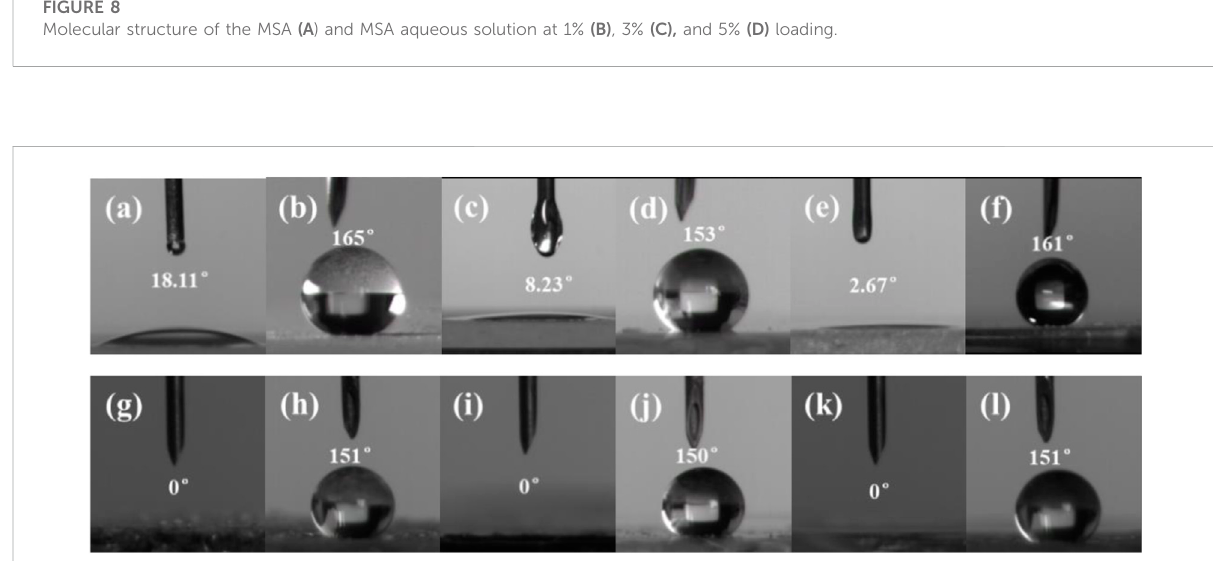
FIGURE 9 In fl uence of the MSA on the contact angle of the solid surface: the water-phase contact angle of the rock core before (A) and after treatment (B) , of the metal before (C) and after treatment (D) , and of the fi lter cake before (E) and after treatment (F) ; oil-phase (paraf fi n) contact angle of the rock core before (G) and after treatment (H) , of the metal before (I) and after treatment (J) , and of the fi lter cake before (K) and after treatment (L)